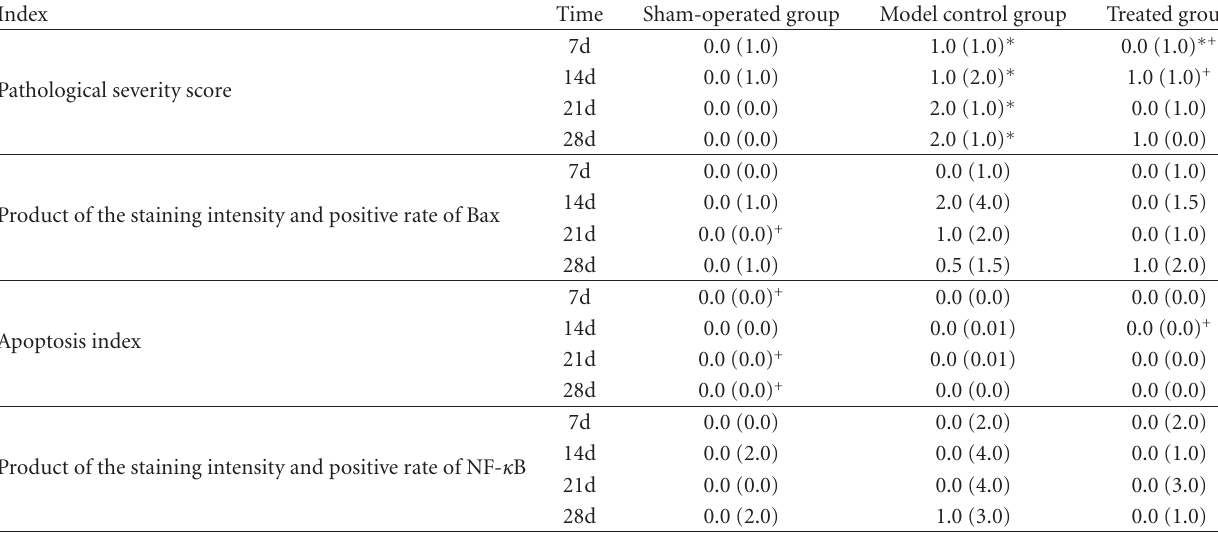
Table 1: Comparison of di ff erent pathological indexes ( M ( Q R